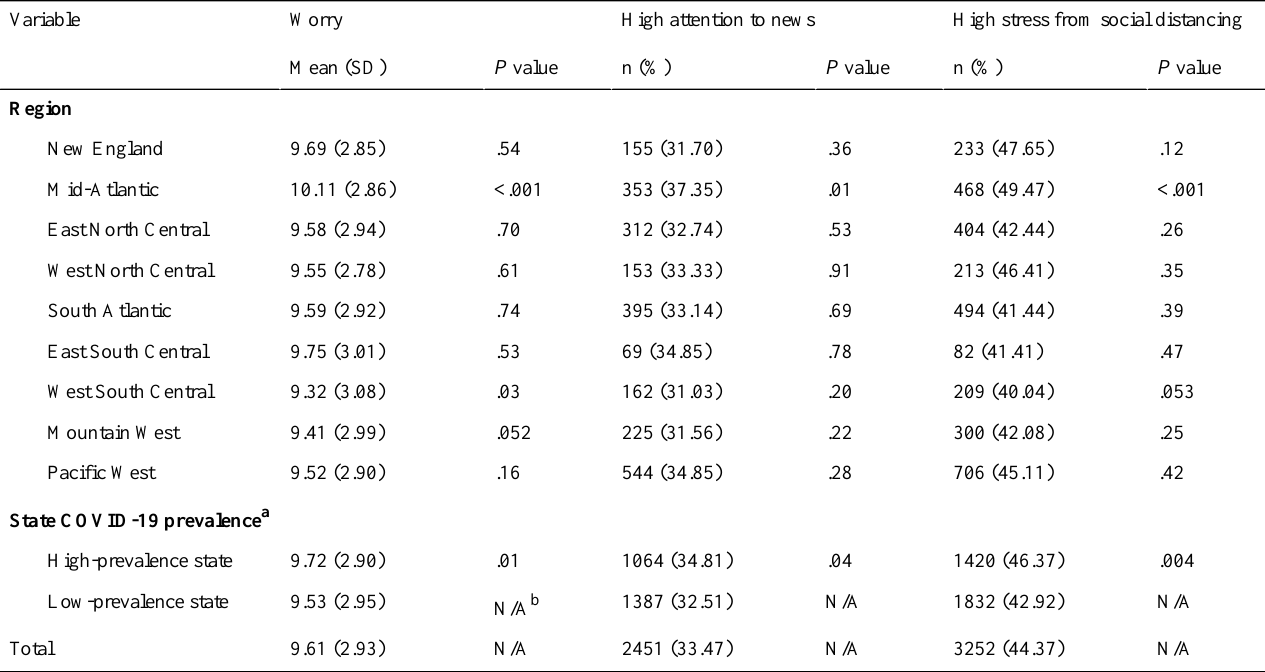
Table 4. Differences in COVID-19–related worry, attention to news, and stress by region and state-level COVID-19 prevalence.